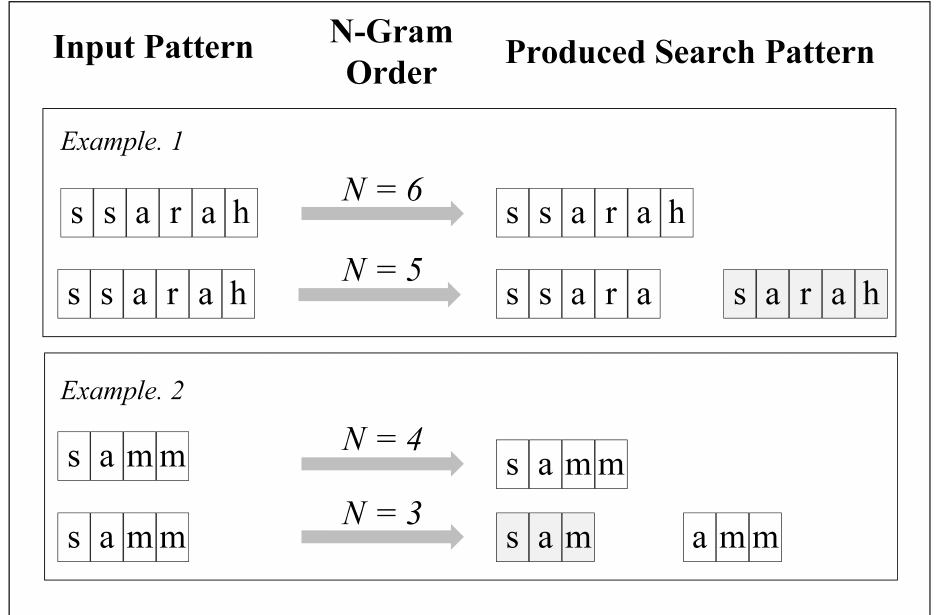
Figure 2. An illustration of using the n-gram model for synthesizing the search